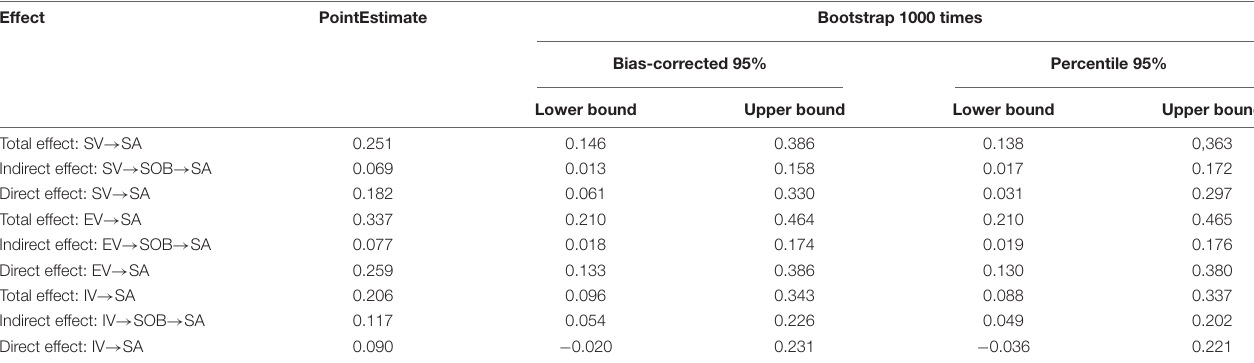
TABLE 10 | The analysis of mediating